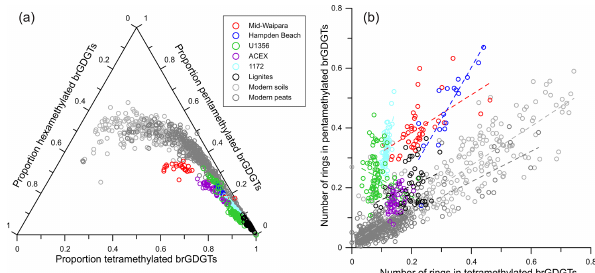
Figure 5. Distribution of brGDGTs in present-day mineral soils (Naafs et al., 2017a) and peats (Naafs et al., 2017b), compared to that in early Paleogene marine sediments (Weijers et al., 2007; Bijl et al., 2013; Pancost et al., 2013) and terrestrial lignites (Naafs et al., 2018): (a) a ternary plot showing relative proportions of tetra-, penta- and hexamethylated brGRGDTs; (b) a cross-plot showing the average number of cyclopentane moieties (rings) for tetra- and pentamethylated